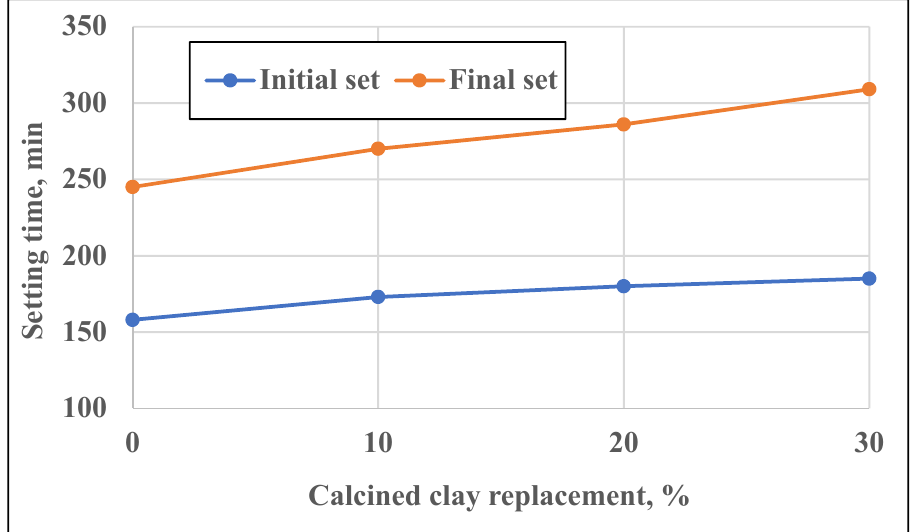
Figure 7 . Setting times of calcined clay blended cements with varying percentage replacements.